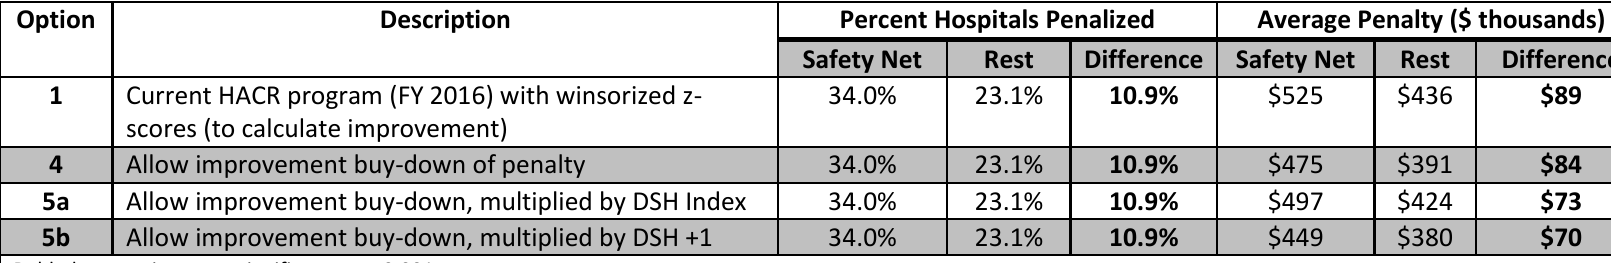
Table 6.26b Improvement Policy Options – Safety-Net Versus Other Hospitals Option Current HACR program (FY 2016) with winsorized z- scores (to calculate improvement) Allow improvement buy-down of penalty